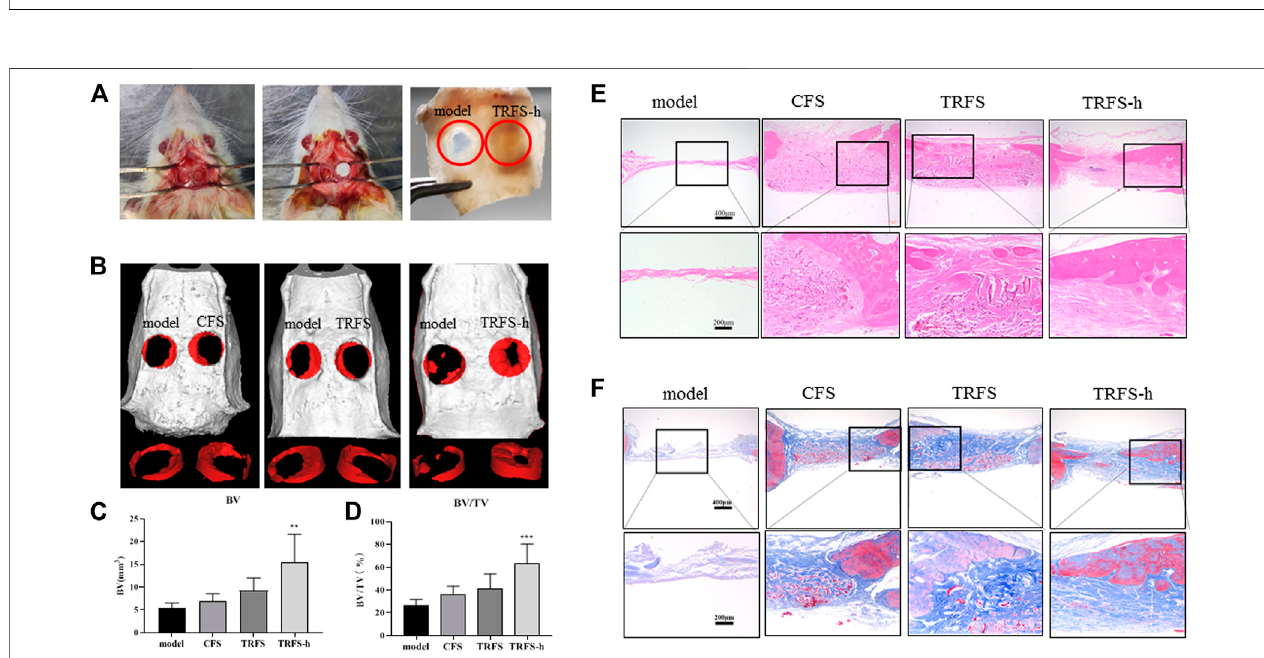
FIGURE3| TRFScontaininghPDLSCswasusedtorepairskullinjuryinSDrats (A) Establishmentandmaterialimplantationofultimateskulldefect(5 mm)modelin rats (B) Micro-CTscanningandthree-dimensionalreconstructionofskulldefectsinSDrats (C) Analysisofnewbonemass (D) Analysisofbonevolumeatthesiteofskull defect (E) HE staining of skull tissue after 12 weeks (F) Masson staining of skull tissue after 12 weeks ( n (cid:1) 6, ** p < 0.01, *** p < 0.001 vs model).